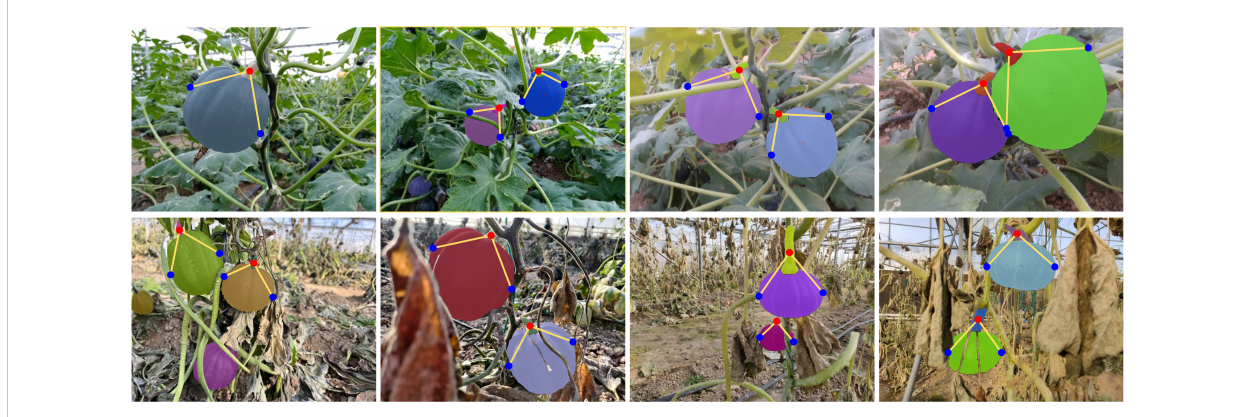
FIGURE 15 Visualized results of grasping and cutting keypoint